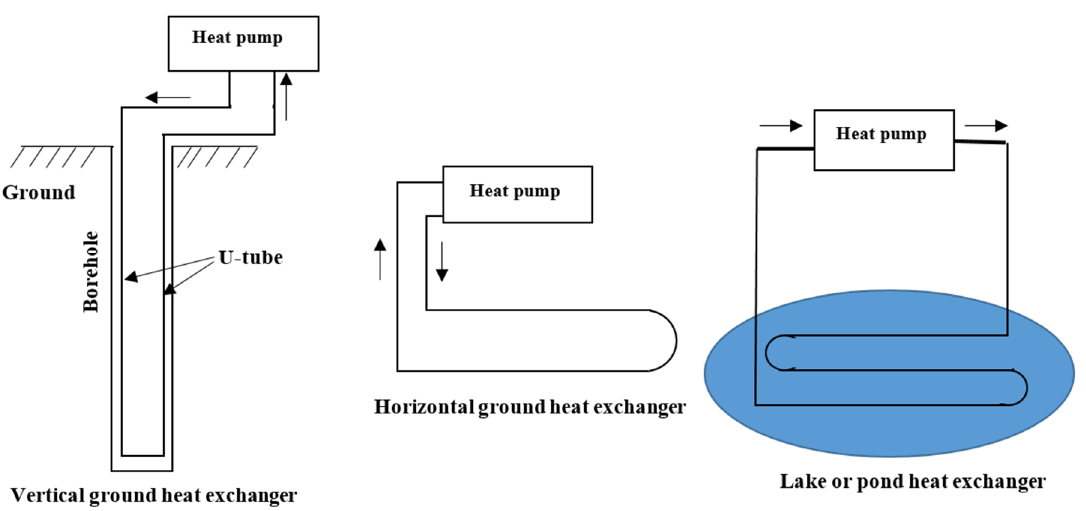
Figure 3. Schematics of different closed ground heat exchangers [6].